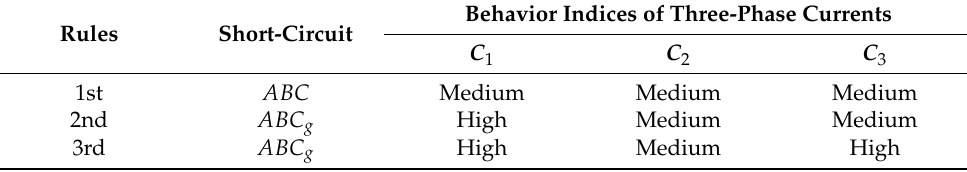
Table 4. FIS rules set to classify three-phase